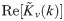
Robustness of periodic connectivity patterns when multiple waves traverse the inputs simultaneously.
A & B. Examples of synaptic strength evolution over time for simulations in which: A) waves are generated with IWIs drawn from an approximately lognormal distribution; B) waves are generated regularly with a constant IWI. C & D. Power spectra for the connectivity patterns, normalized by the maximum in each spectrum, for simulations in which: C) IWIs are drawn from a lognormal distribution. Light blue to black corresponds to mean IWIs of 2.0 s, 1.0 s, 0.5 s, 0.2 s and 0.15 s, respectively; D) IWIs are constant. Color scheme the same as for C. E. Robustness of connectivity patterns as a function of the mean IWI. Reference power spectra are taken from simulations with a constant IWI of 5 s. Black: IWIs drawn from a lognormal distribution. Grey: IWIs are constant. F. An example of Re[K~v(k)] (black) and examples of Re[α~p(vk)] for a single wave in isolation (grey) and multiple waves with constant IWIs of 1 s (blue) and 0.15 s (pink). G. Examples of Re[K~v(k)∣α~p(vk)∣2] for the same IWIs in F.